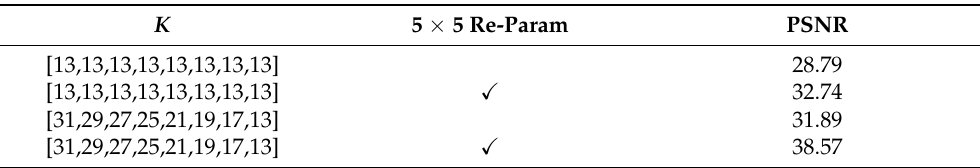
Table 4. Ablation experiments for the large conv kernel size K and 5 × 5 re-parameterization in LK blocks.